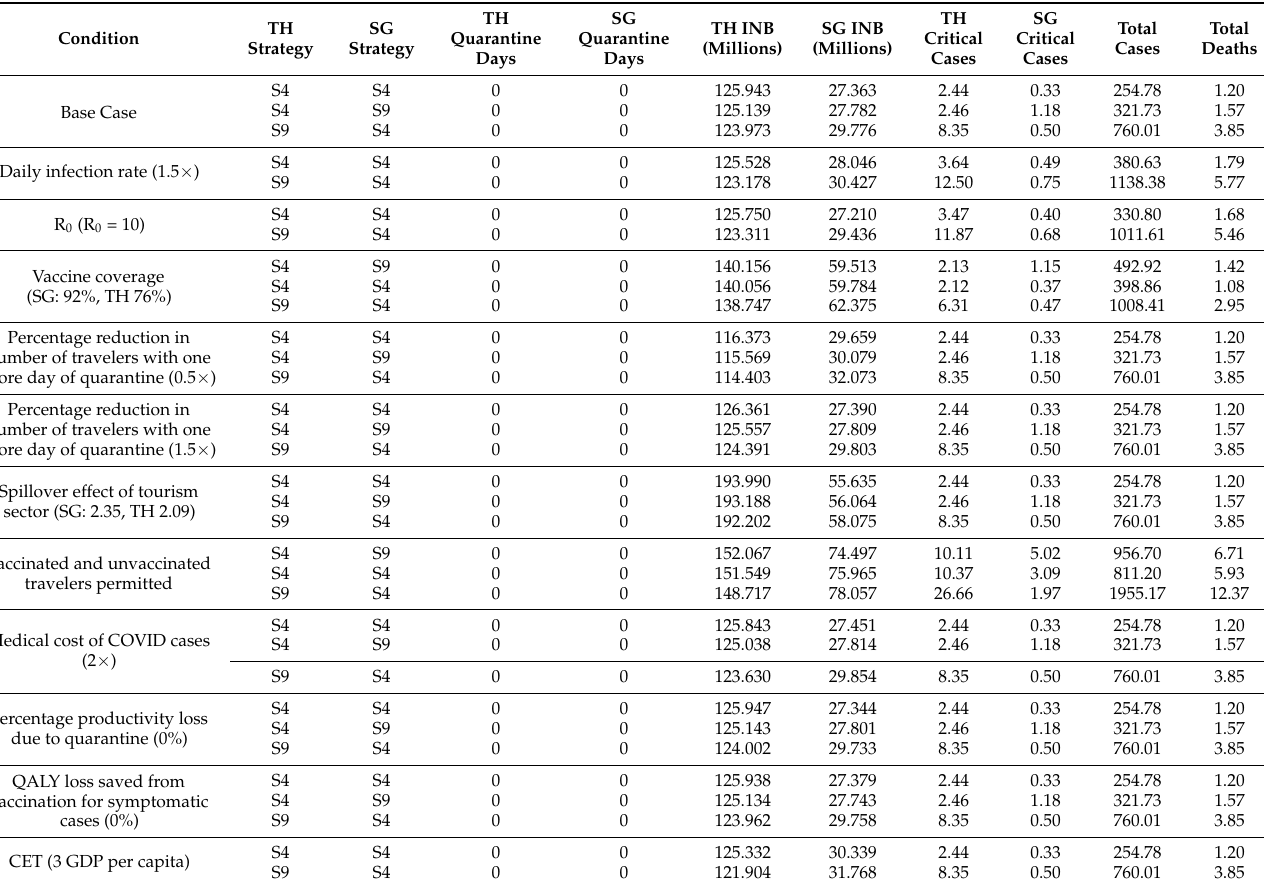
Table 4. Pareto optimal policies from Deterministic Sensitivity Analysis (all numbers are per- month